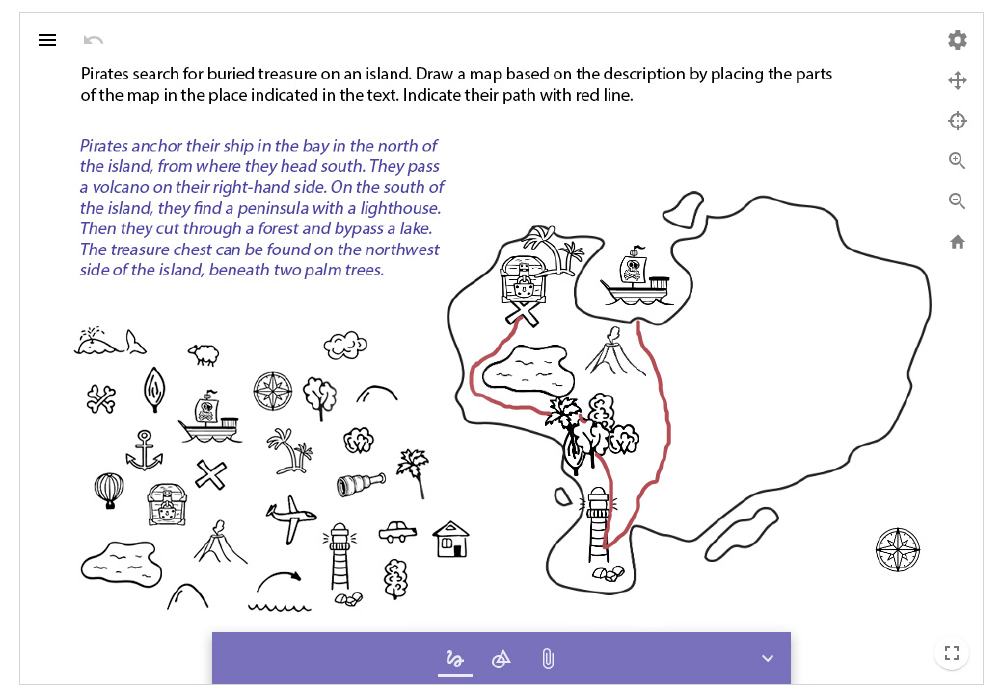
Figure 3. Creating a map with graphic symbols.